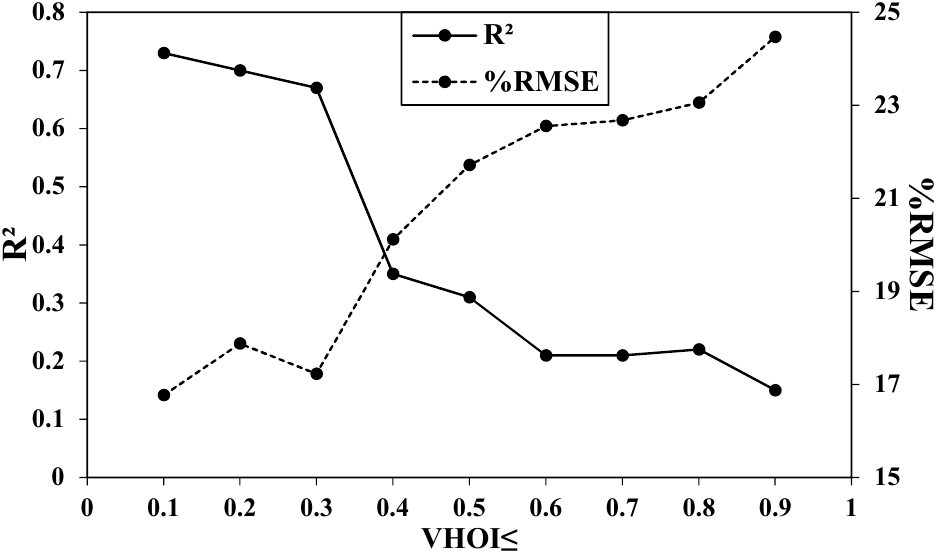
Figure 4. Changes in R 2 (solid line) and %RMSE (dotted line) with different value of VHOIs.